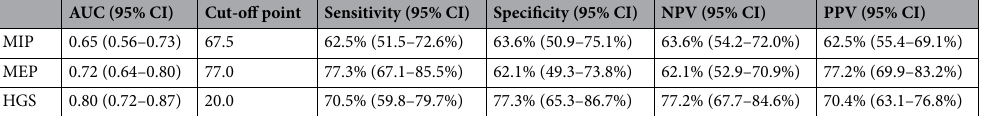
Table 3. Cut-off points, AUC, sensitivity, specificity, NPV and PPV of muscle strength tests to screening sarcopenia. MIP maximal inspiratory pressure, MEP maximal expiratory pressure, HGS hand grip strength, AUC area under the ROC curve, NPV negative predictive value, PPV positive predictive